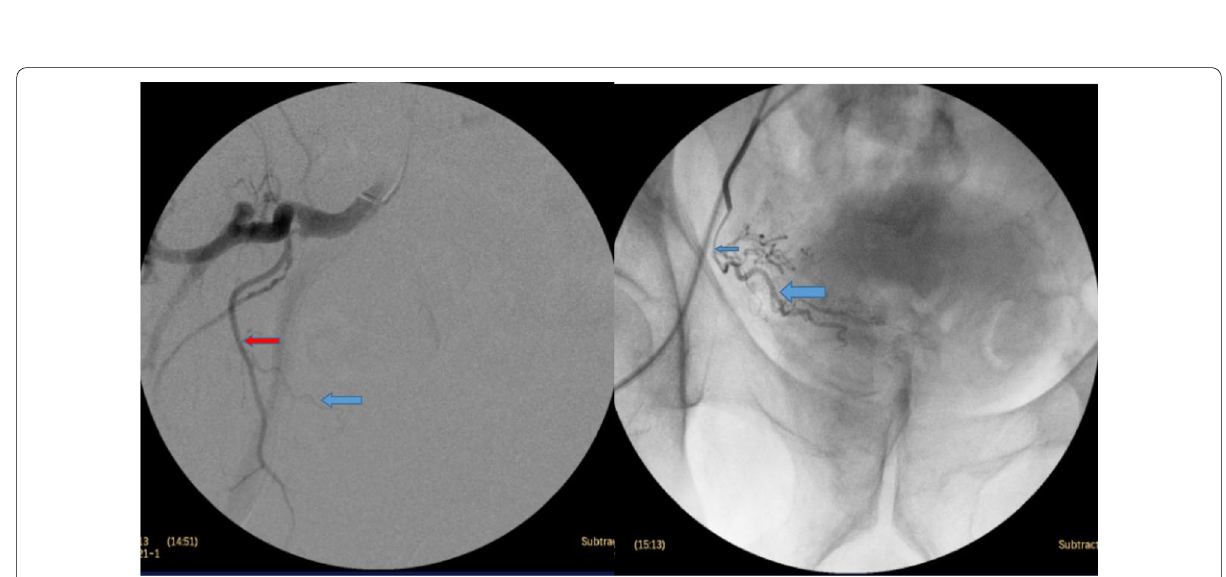
Fig. 8 Angiography images showing the origin of right prostatic artery (blue arrow) from obturator artery (red arrow), from posterior trunk of